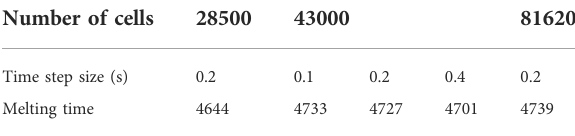
TABLE 2 Effect of grid size and time step size on the charging